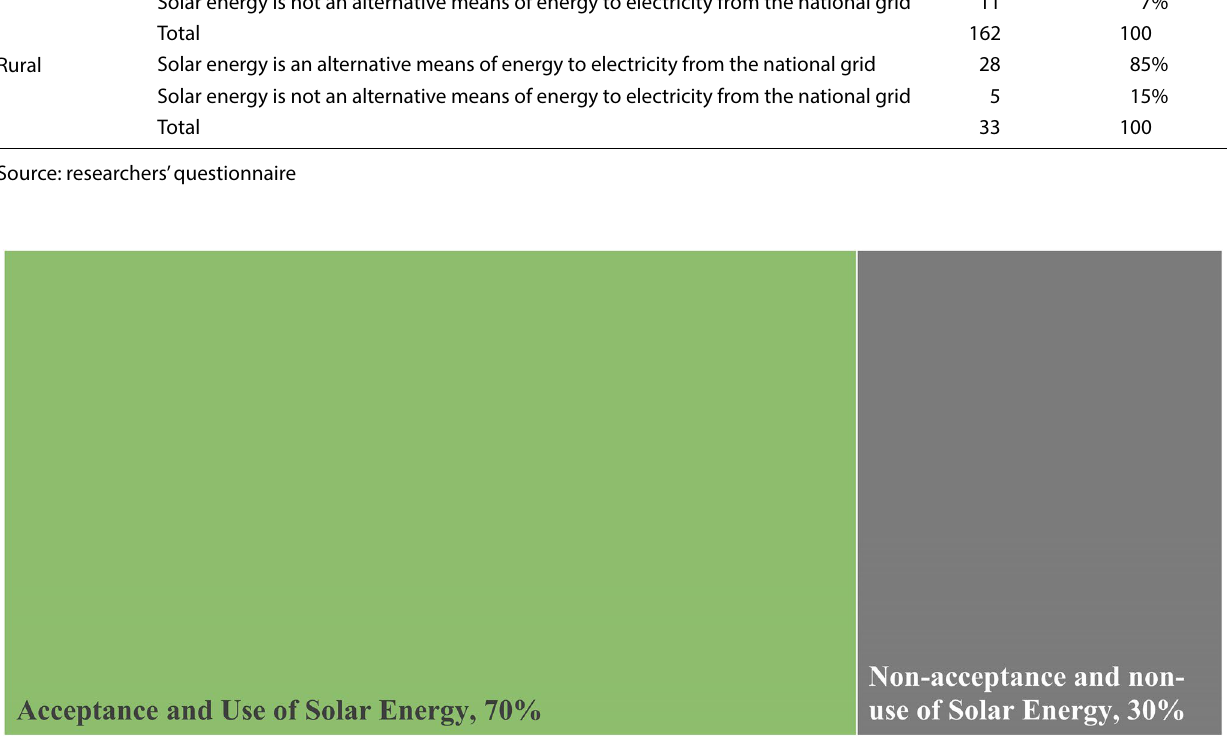
Fig. 5 Acceptance and Use of Solar Energy amongst SMEs in Lagos State, Nigeria. Source: Researchers’